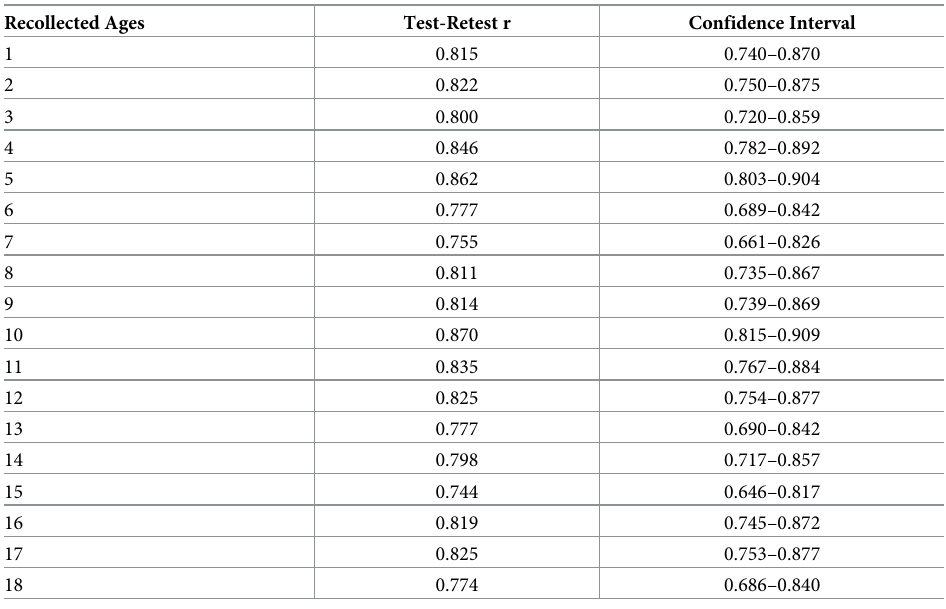
Table 12. Test–retest reliability by